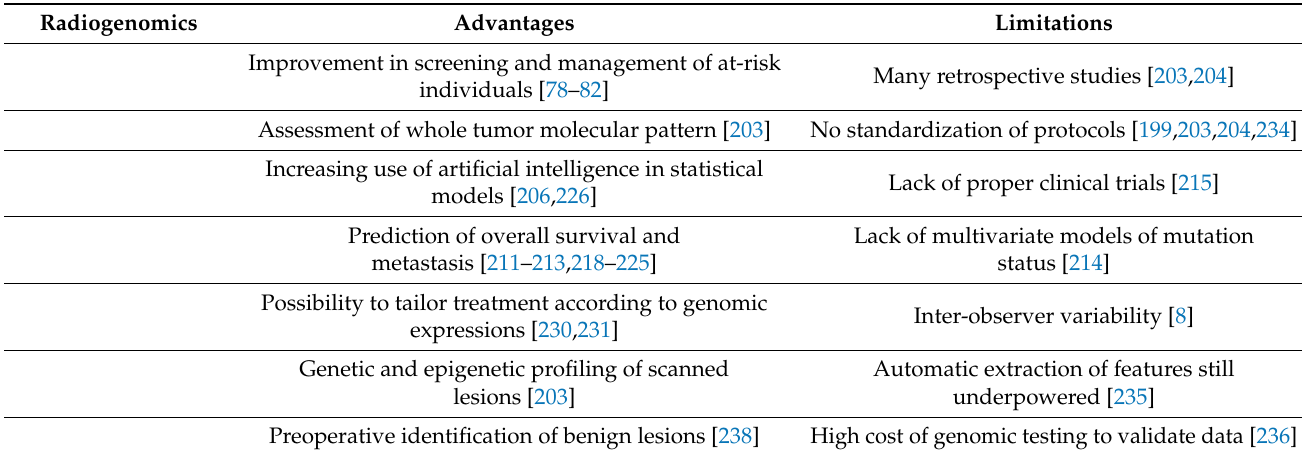
Table 1. Advantages and limitations of renal